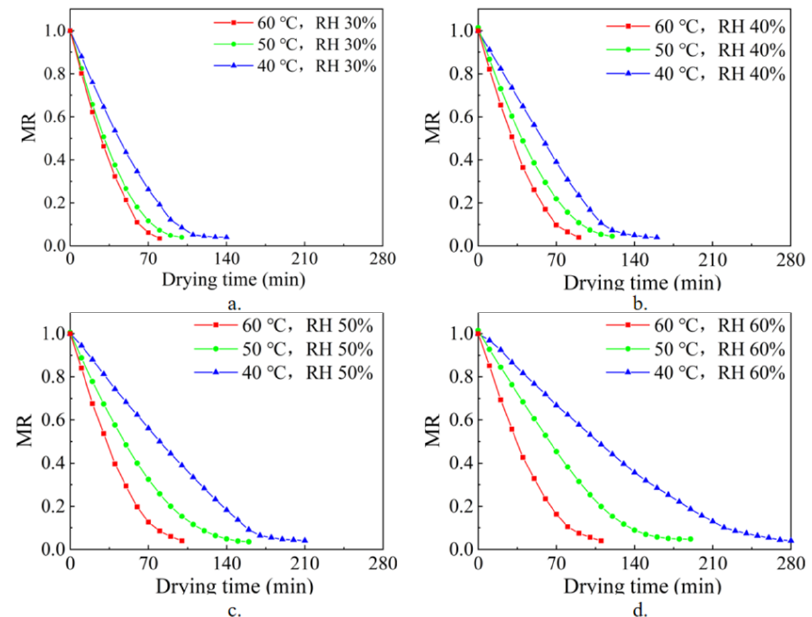
Figure 3. Sludge MR versus drying time for different relative humidities: ( a ) 30%, ( b ) 40%, ( c ) 50%, and ( d ) 60%.